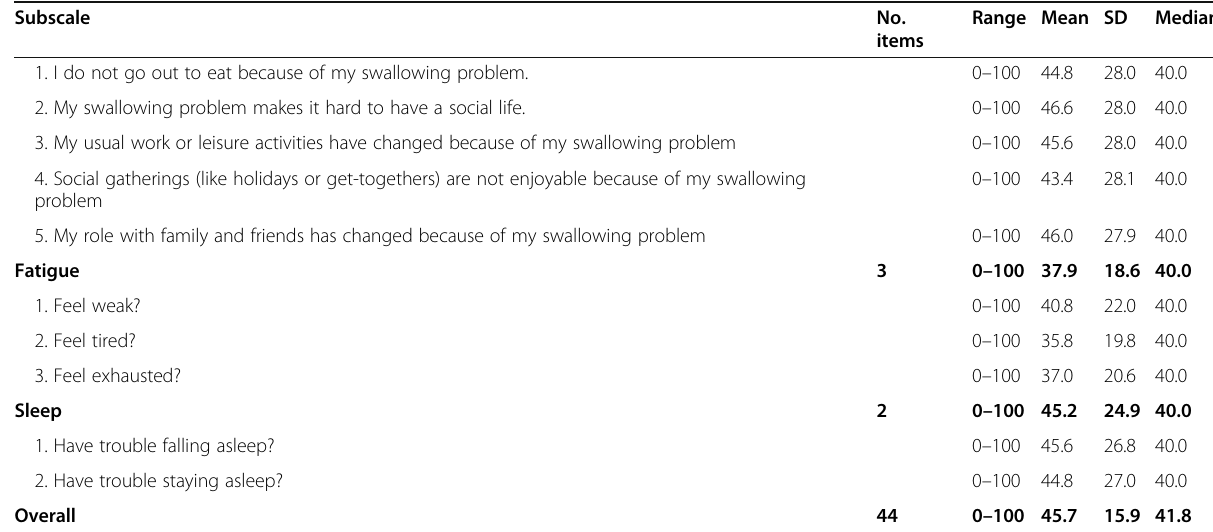
Table 3 Score distribution of ASWAL-QOL ( n = 100) (Continued) Subscale No.